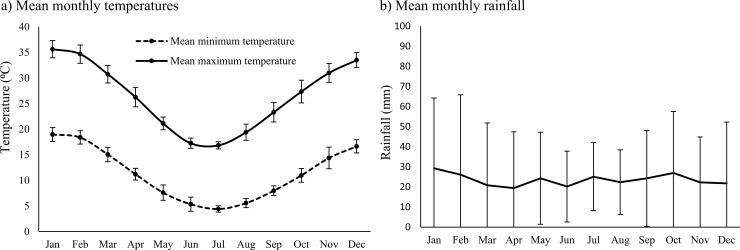
(a) Mean monthly minimum and maximum temperatures from 2003–2016, and (b) mean monthly rainfall, from 1956–2016, at the study site. Unlike most other arid zones, there is no predictable wet season.